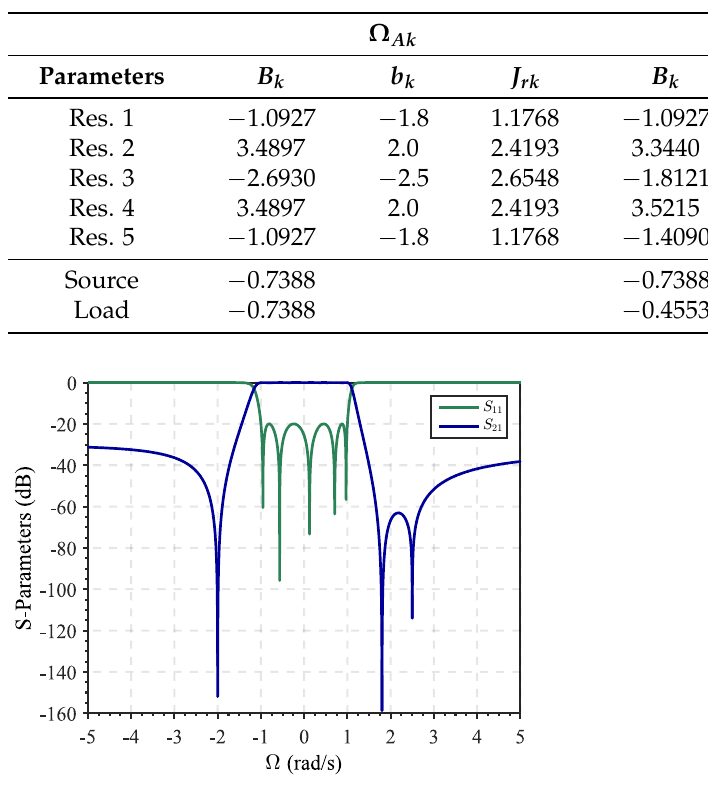
Table 1. Extracted elements of the 5th-order filter prototype with Ω Ak and Ω Bk TZs distributions.